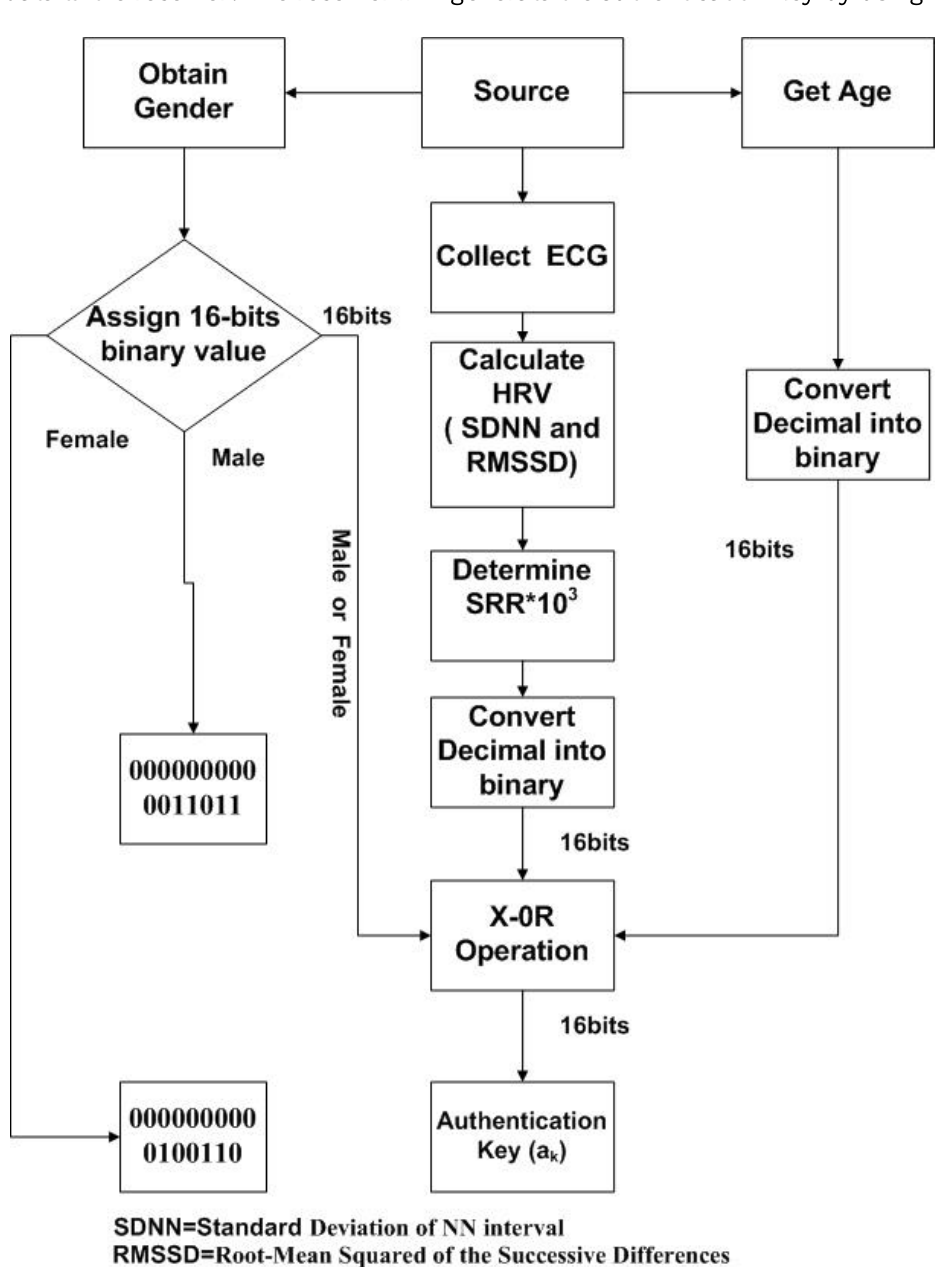
Figure 5. The key generation procedure for proposed